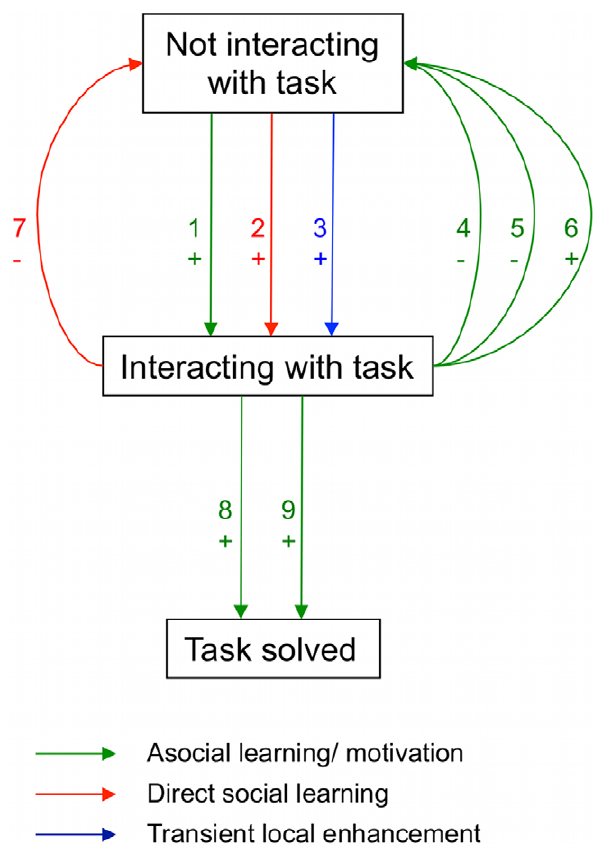
Figure 2. Diagrammatic representation of all effects found. Each effect is described and interpreted in Table 1. The positioning of the arrow for each effect represents the transition rate affected. Green arrows mean a rate of transition was found to be a function of an individual’s previous manipulations of the task, interpreted as asocial learning or changes in motivation. Red arrows mean a rate of transition was found to be a function of the number of previous observations, interpreted as direct social learning. The blue arrow indicates the rate of interaction was found to be a function of the time since last observation at each option, interpreted as a transient local enhancement effect. + or - indicates whether the transition rate was positively or negatively associated with the variable in